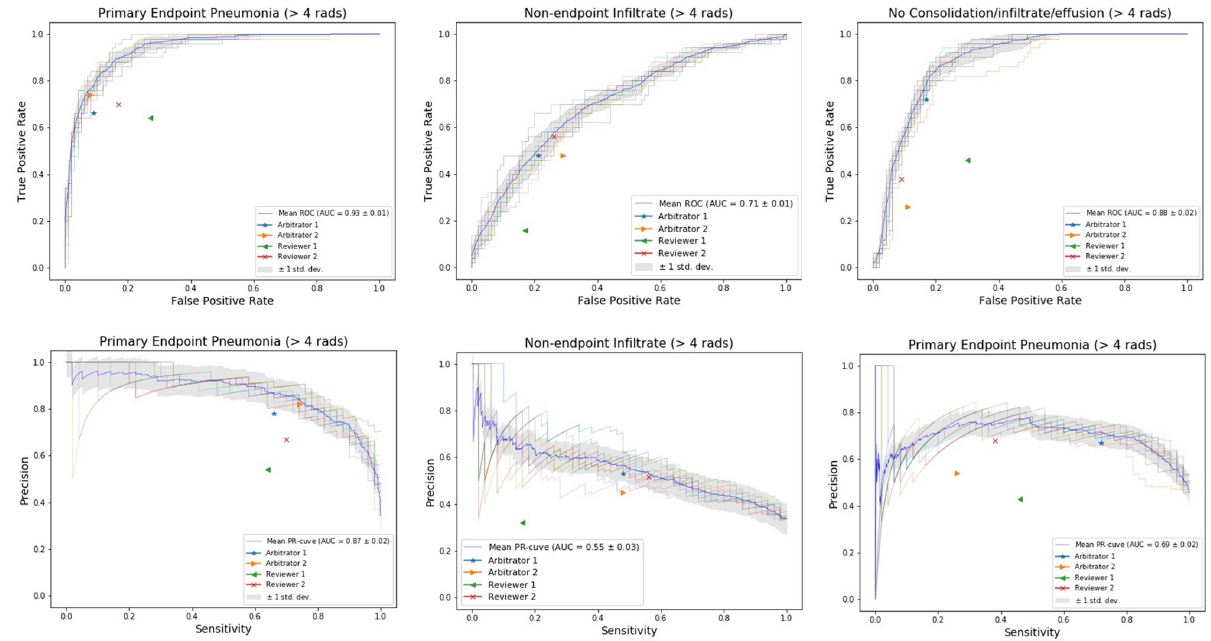
Fig 2. Comparison of model performance to radiologist and pediatricians on discordant images. The four operating points represent the conclusions given by the 4 readings. The lines represent model’s performance, with the average of 10-fold validation in blue color. The top rows shows the receiver operating characteristic (ROC) curve and the bottom shows the Precision-Recall (PR)